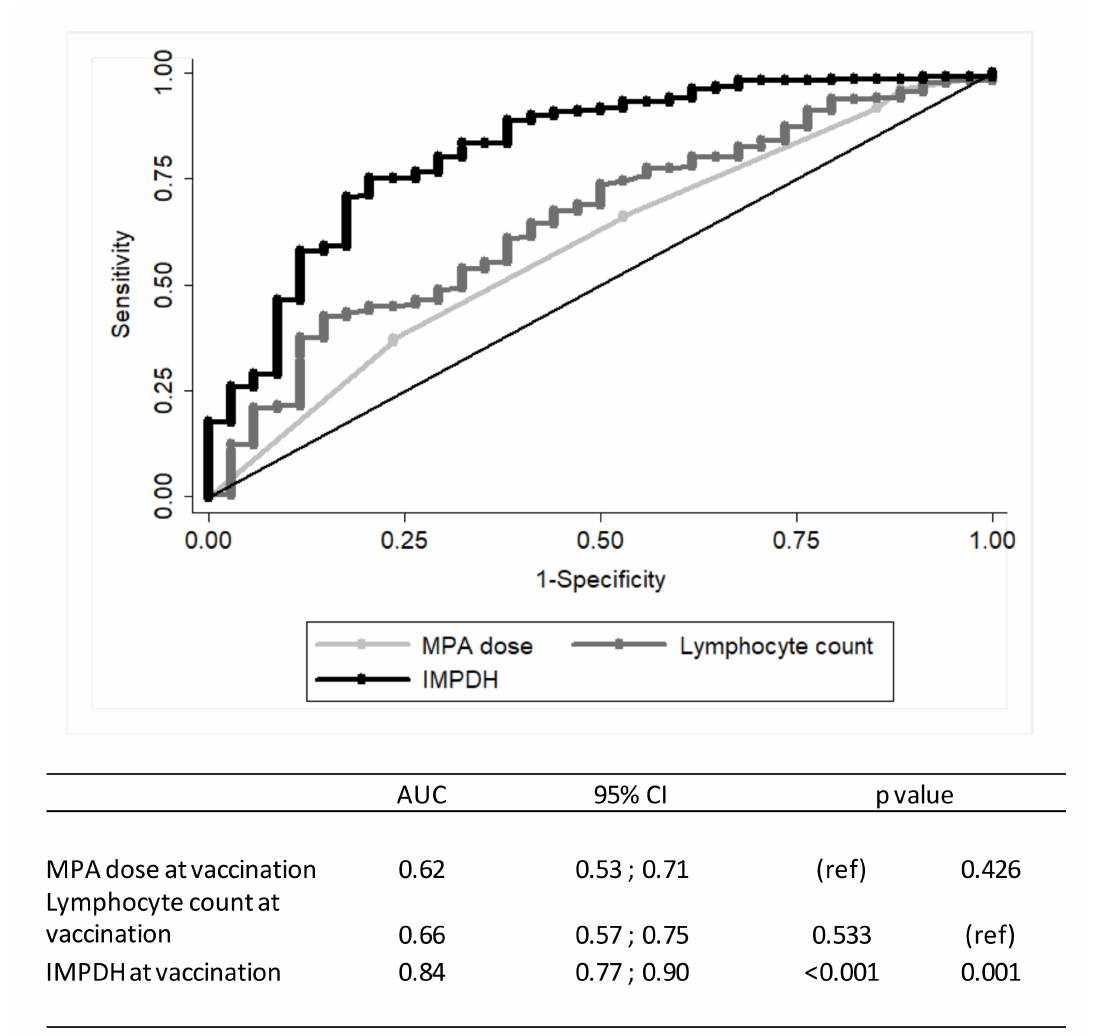
Figure 2. Predictive performance for response to SARS-CoV-2 vaccination after kidney transplantation ( n = 348 MPA-treated patients with IMPDH measurement). (ref) = reference